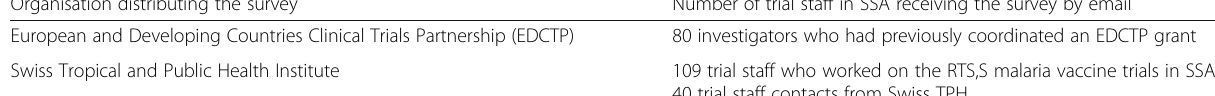
Table 1 Survey distribution Organisation distributing the